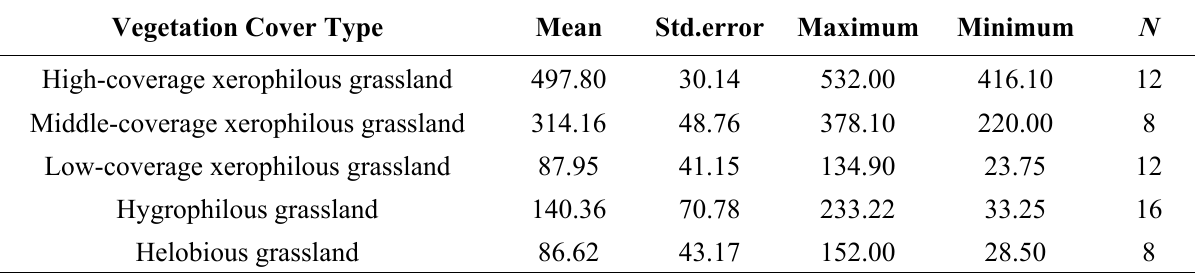
Table 1. The statistics of field-measured net primary productivity (NPP) (gC·m − 2 ·a − 1 ) for different vegetation covers in the Zoige Plateau wetlands ( N : the number of field plots).